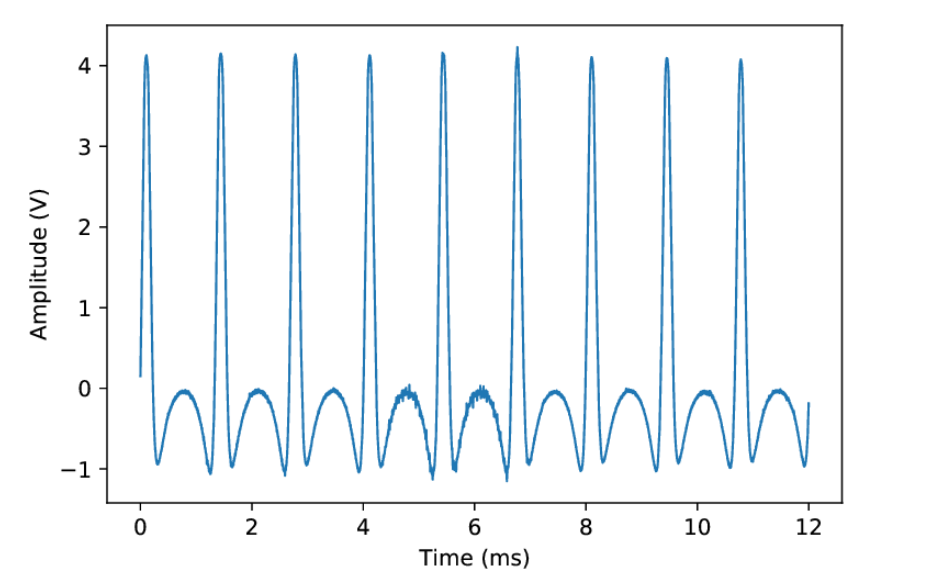
Figure 10. Output signal at 1100